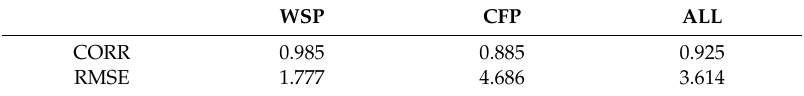
Figure 4. Time series of the observed ( red line ) and simulated ( blue line ) mean hourly rainfall amount. Yellow line represents the difference between simulation and observation. Regional averaging is performed over the black box in Figure 3a1. Table 1. Statistical results of the observed and simulated hourly rainfall amount.